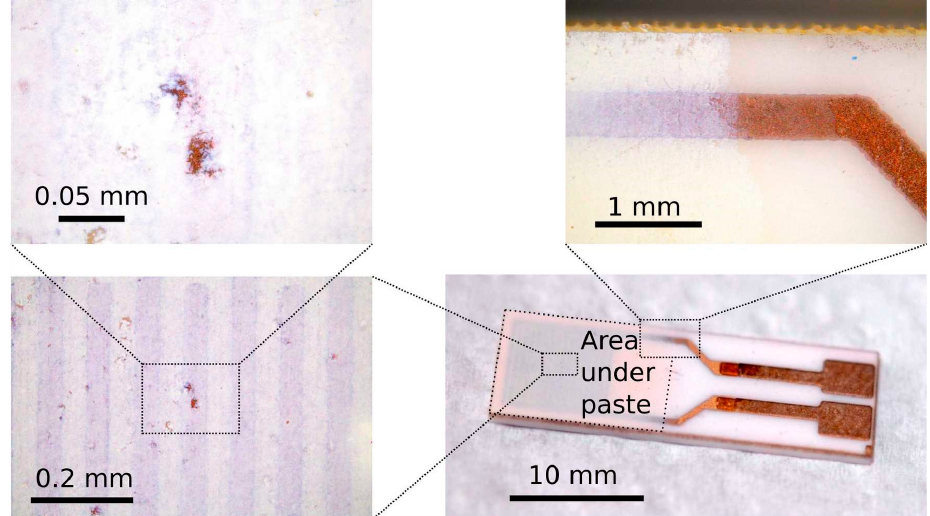
Figure 5. Optical microscopy of the sensor based on the TiCe-0.8:0.2-40 mixture.